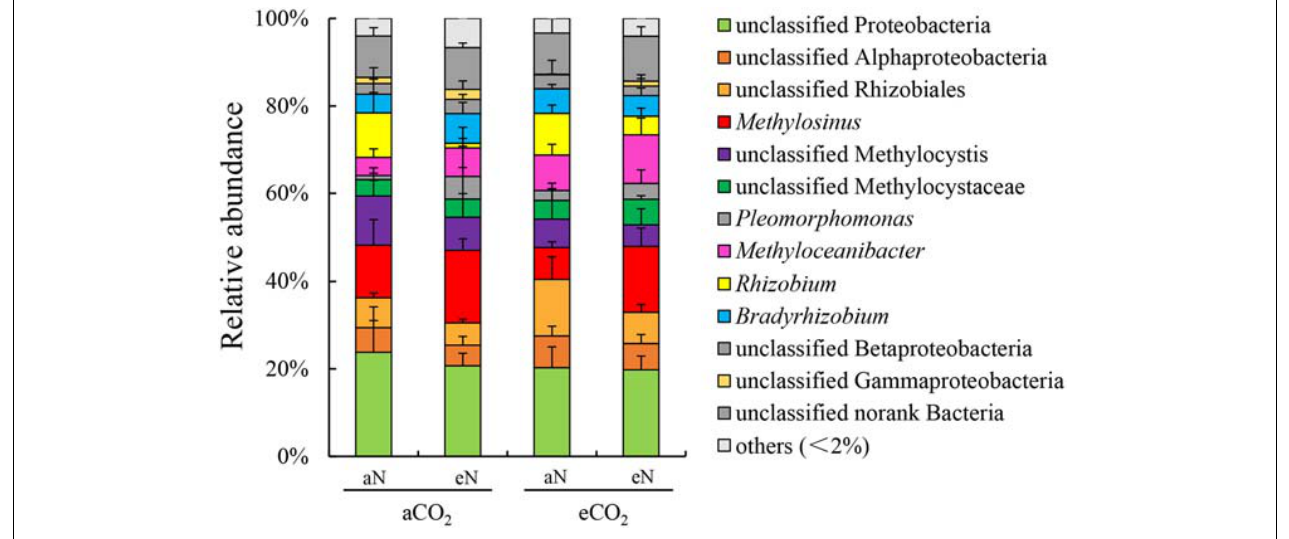
FIGURE 4 | Relative abundance, at the genus level, of N 2 -fixing bacterial communities of rice roots at the heading stage under elevated CO 2 and nitrogen fertilization treatments. aCO 2 , ambient CO 2 ; eCO 2 , elevated atmospheric CO 2 . aN, no N fertilization; eN, elevated N fertilization.